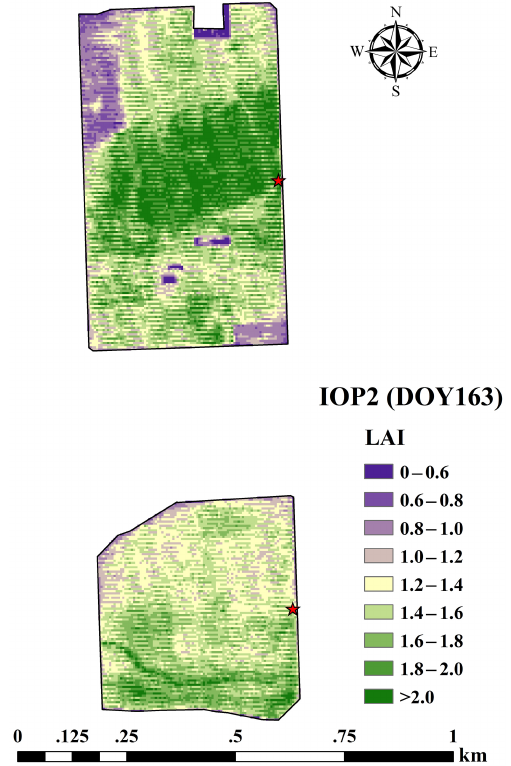
Figure 4. The LAI map generated from the NDVI image for IOP 2 DOY